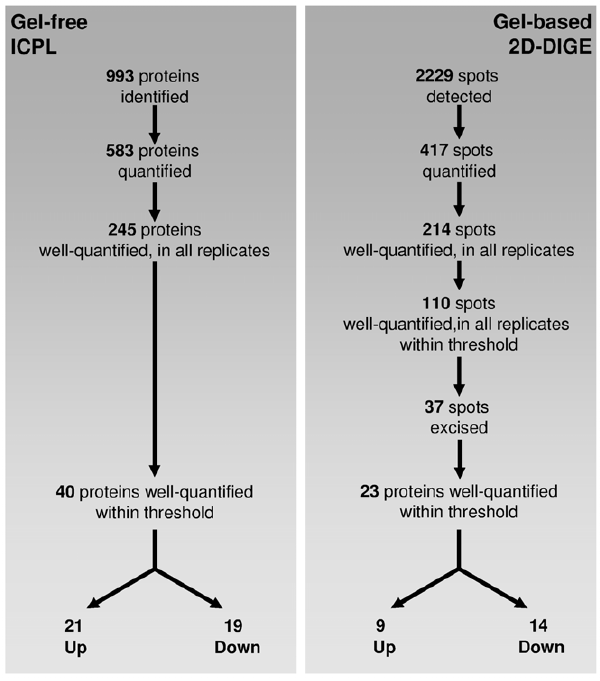
Figure 3. Comparison of the different steps of protein identification and quantification between the two experimen- tal workflows.